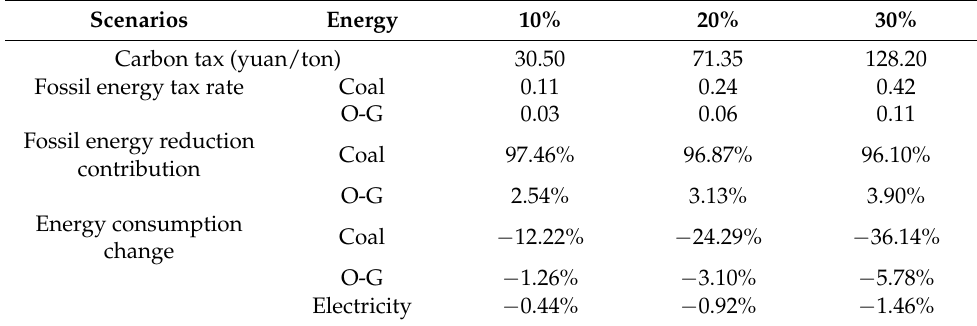
Table 2. The carbon tax and energy